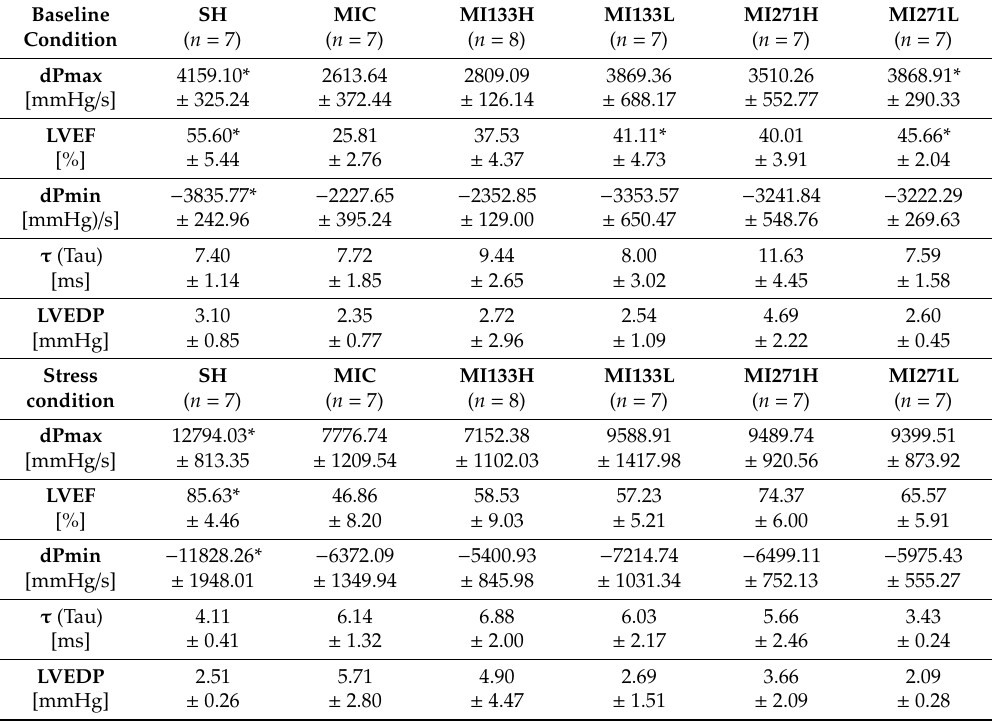
Table 1. Hemodynamiccharacteristicsthreeweekspost-MI.Mean ± SD;* p ≤ 0.05vs. MIC(Mann–Whitney U test; LVEDP—Left ventricular end diastolic